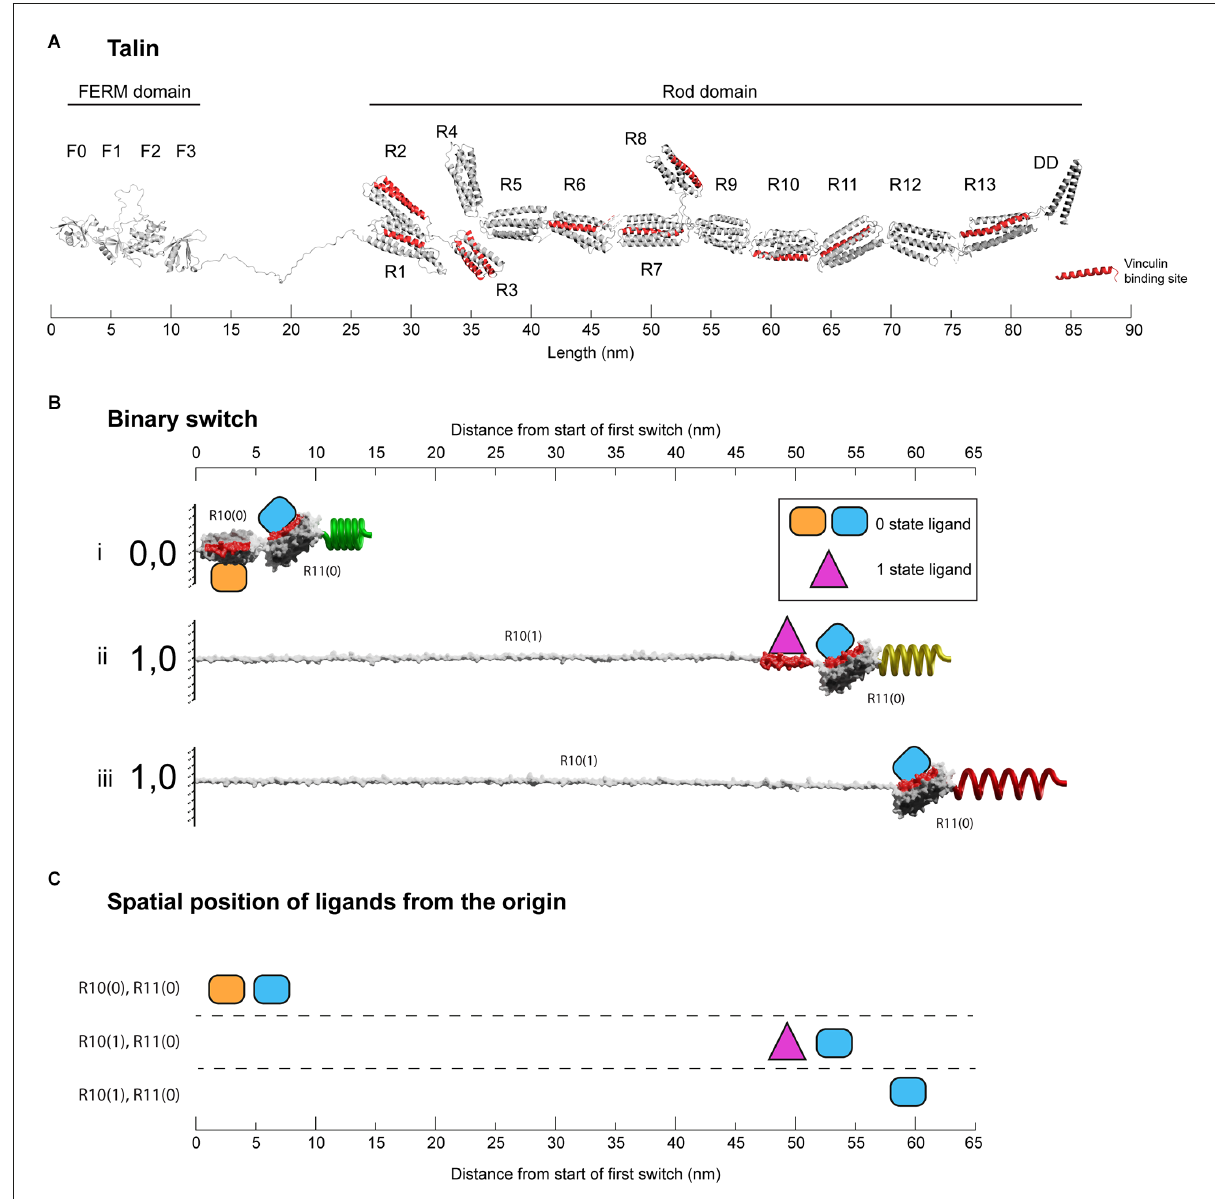
FIGURE2 Binary switches in cells. (A) Structural model of open talin (Goult et al., 2013b). Talin is composed of an integrin-binding N-terminal FERM domain “head”, connected by an 82-residue unstructured linker, to a large flexible rod domain consisting of 61 helices arranged into 13 switch domains (R1–R13). The 62nd helix is a dimerisation domain that forms a dimer with another talin molecule. The 11 VBS helices are shown (red). The length of the talin rod is 55 nm. (B) The changing dimensions of a talin switch domain drawn on the same scale as (A) . Two 5-helix switches, R10 and R11 are shown. (i) In the folded 0,0 state each switch is 5 nm in length. Two signalling molecules are shown bound, orange on R10(0), and blue on R11(0). Both domains contain a vinculin binding site helix (red) that in the 0 state are cryptic and inaccessible. (ii) A force increase (shown by a spring) unfolds the first switch to the open, 1 state. After unfolding, the orange R10(0) ligand is displaced and the purple R10(1) ligand engages the now exposed binding site. Vinculin (purple) also limits the switch refolding back to the 0 state. Non-bound helices unravel extending the molecule. Strikingly, the blue ligand remains bound to R11(0), but its location has been altered by 50 nm. (iii) Vinculin is displaced, either due to force unfolding the VBS helix or other factors. The fully extended switch is 55 nm, 11 × longer than the closed state and comparable in length to the entire fully folded rod in (A) . (C) Spatial map of ligands for the two switches in the 0 and 1 states. In this figure the distances are measured from the start of the first switch, however, in the cell these distances would be from the attachment points where the talin is bound to the integrin. All molecules engaging the switches have a coordinate position a fixed distance away from the origin.